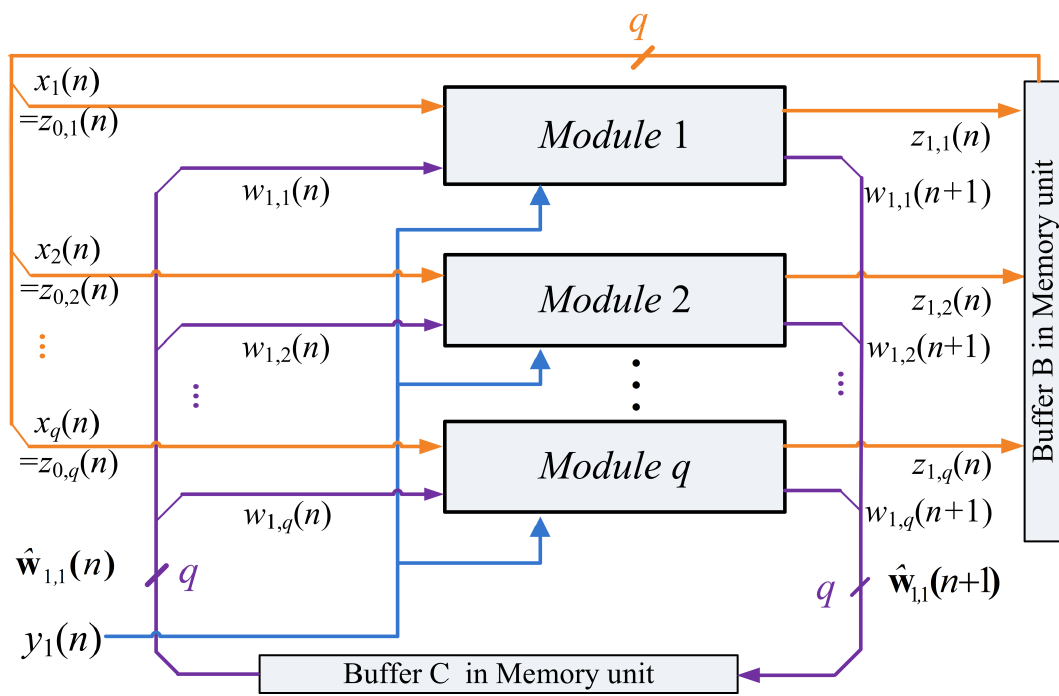
Figure 5. The SWU unit operation for computing the first segment of w